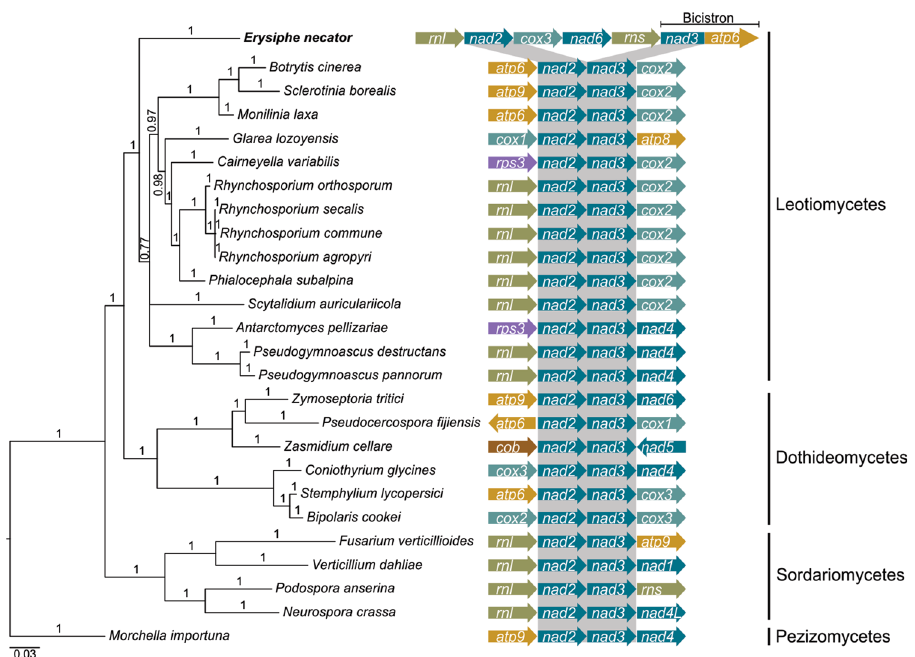
Figure 2. The mitochondrial (mt) genome of Erysiphe necator has an atypical organization of the nad2 and nad3 genes. A Bayesian phylogenetic tree of the mt genomes of E. necator and 25 other Ascomycetes is shown on the left-hand side of the image. The phylogenetic tree was inferred with MrBayes based on the concatenated alignment of the protein sequences of 12 mt genes ( atp6 , nad1 - 6 , nad4L , cox1 - 3, and cob ). For comparison, a phylogenetic tree based on the nuclear genomes is shown in Supplementary Fig. S8. Supporting values of branches are indicated as Bayesian posterior probabilities. Morchella importuna was used as outgroup. On the right-hand side of the image, the gene organization on each side of the nad2 and nad3 genes is indicted for the species shown in the tree. Genes are represented as arrows and are shown in the same order as they appear in the mt genomes. The nad2 and nad3 genes are typically next to each other in fungal mt genomes but not in the mt genome of E. necator, in which nad3 and atp6 are instead expressed bicistronically in the same RNA transcript. Accession numbers of the sequences utilized to construct the tree are available in Supplementary Table S12. The phylogenetic tree was edited with FigTree v1.4.2 66 (http:// tree. bio. ed. ac. uk/ softw are/ figtr ee/) and the figure was created with Inkscape v1.0.2 (https:// inksc ape.